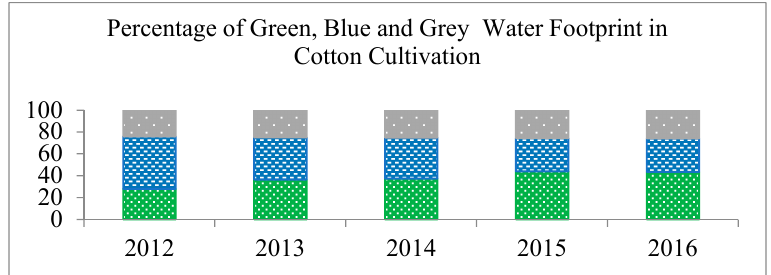
Figure 4. Percentage of green, blue and grey water footprint of cotton cultivation.